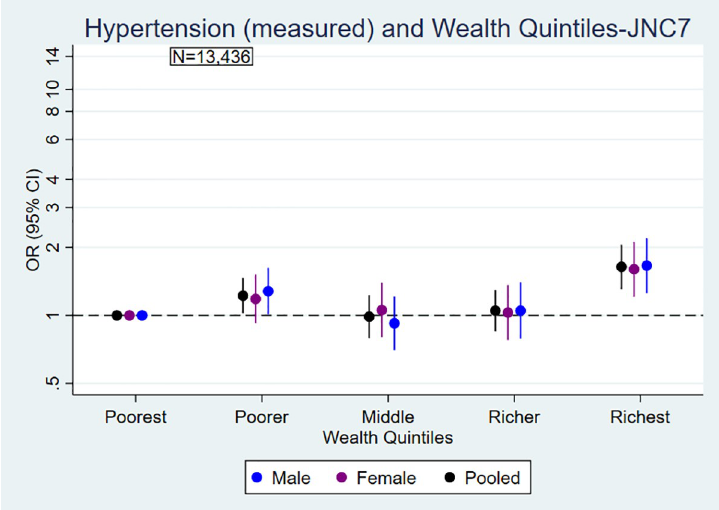
Fig 2. Association of (a) hypertension and (b) normal blood pressure (measured) with wealth quintiles by sex in Nepal. a) Hypertension and Wealth Quintiles b) Normal Blood Pressure and Wealth Quintiles. Odds ratios are adjusted for age, urbanity and marital status, and stratified by sex. Measurement-only outcomes are defined based on cut-off points: hypertension: SBP � 140mmHg or DBP � 90mmHg; normal blood pressure: SBP � 120mmHg and DBP � 80